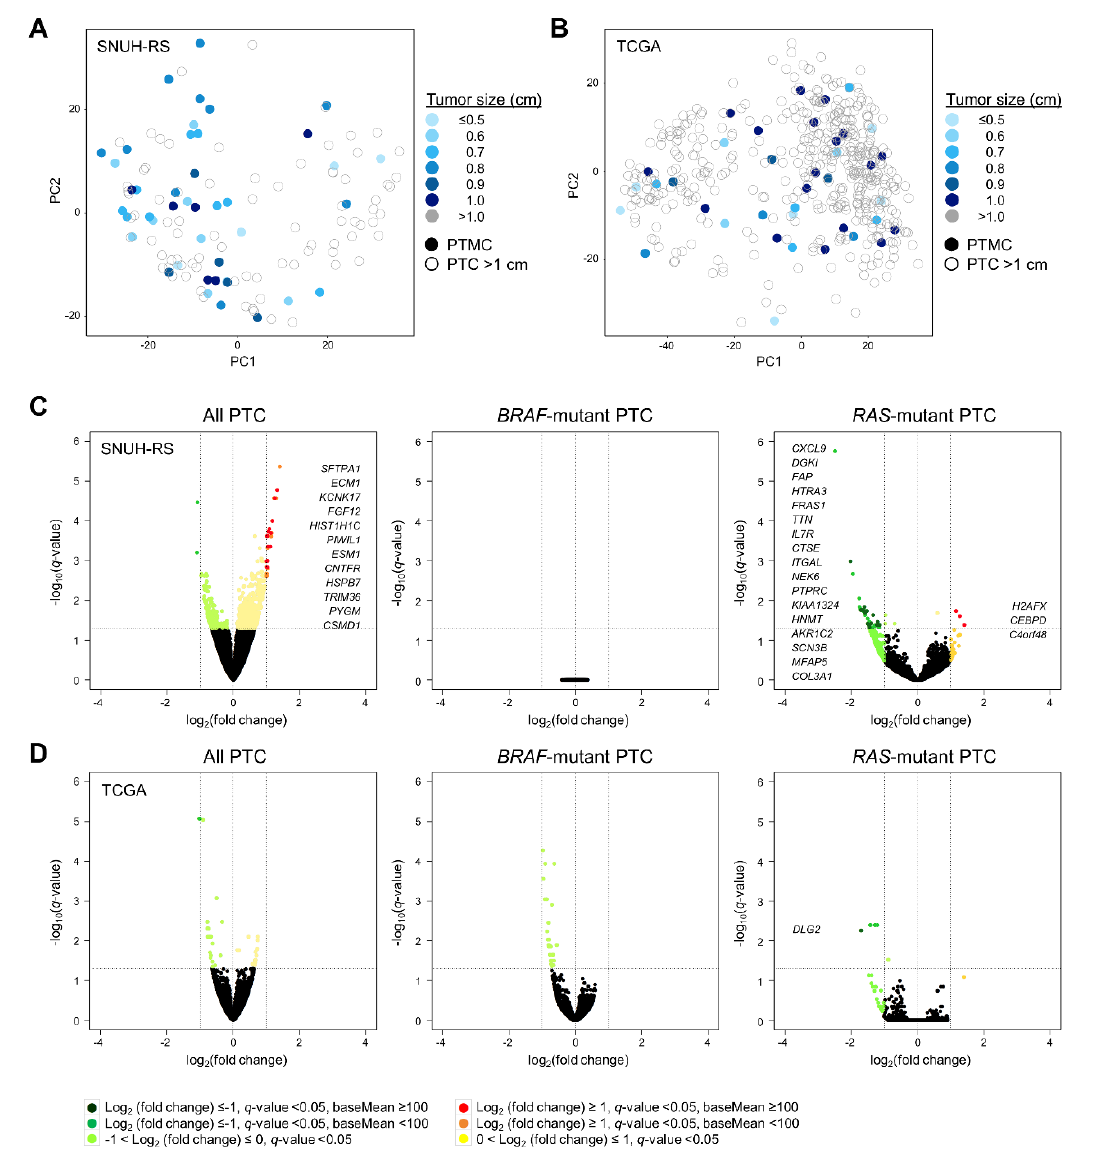
Figure 2. Transcriptomic characteristics of papillary thyroid microcarcinoma. Principal component analysis plot of PTC from the ( A ) SNUH RNA-sequencing (SNUH-RS, n = 124) and ( B ) TCGA ( n = 496) datasets. Volcano plots showing di ff erential RNA expression levels between PTMC and PTC > 1 cm in all PTCs (left), BRAF mutant PTCs (middle), and RAS mutant PTCs (right) from the ( C ) SNUH-RS ( n = 43 vs. 81, 29 vs. 37, 4 vs. 20, respectively) and ( D ) TCGA ( n = 39 vs. 457, 18 vs. 217, 3 vs. 49, respectively) datasets. Up- and down-regulated DEGs in PTC > 1 cm compared to PTMC are marked in dark red and dark green, respectively. PTMC, papillary thyroid microcarcinoma; PTC, papillary thyroid carcinoma.